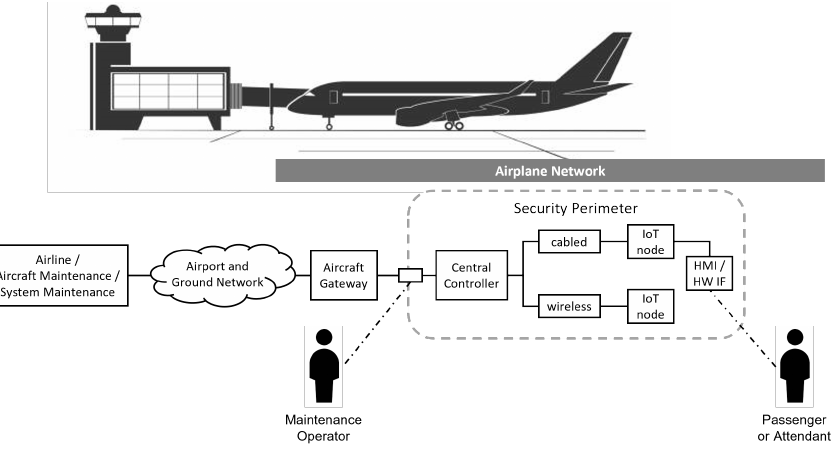
Figure 3. Connected Aircraft